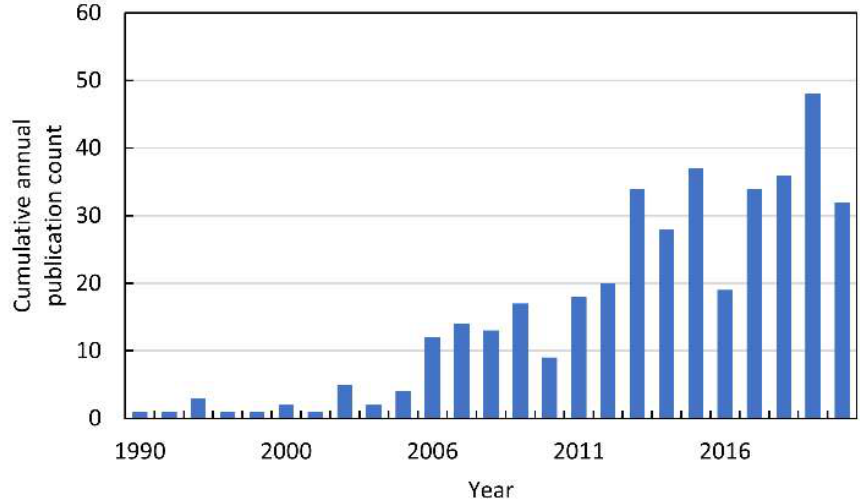
Figure 3. The cumulative annual publication count of papers on ROS in allelopathy. Details of the search are described in Supplementary Materials.